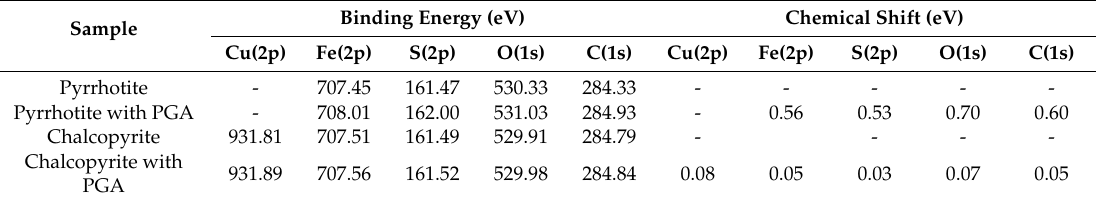
Table 4. Binding energies of important species in the absence and presence of 50 mg / L PGA at pH